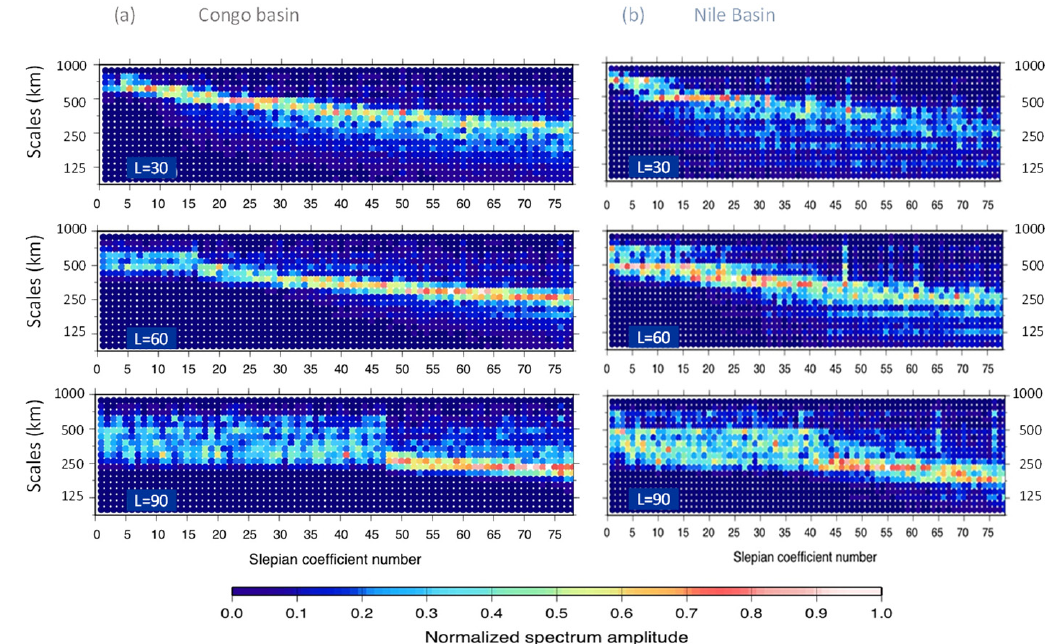
Figure 4. Impact of the bandwidth L on the spatial scale analysis ( a ) for the Congo watershed. For L = 30, the maximum amplitudes are for a scale ranging from 1000 km to 500 km. For a coefficient number of ~30 and for L = 60, the amplitude spectrum is more linear with a strong amplitude for a scale ranging from 500 km to ~300 km and for a coefficient number ranging from 30 to 75; for L = 90, the spectrum shows for each coefficient a large range of scales, the linear part with more concentrated scales starts at ~300 km for a coefficient number around 47 to 200 km and for a coefficient number of 75; ( b ) for the Nile watershed, for L = 30, the maximum amplitudes are for a scale ranging from 1200 km to 500 km and for a coefficient number ~30. For L = 60, the spectrum is less linear than that of the Congo watershed (Figure 3) but the energy is more dissipated between different scales ranging from 500 km to ~250 km for Slepian coefficient numbers ranging from 4 to 70; for L = 90, the spectrum shows for each SF coefficient, as for the Congo watershed, a broad range of spatial scales, the linear part starts at ~300 km for coefficients around 44 to 200 km and for an SF coefficient number of 75.